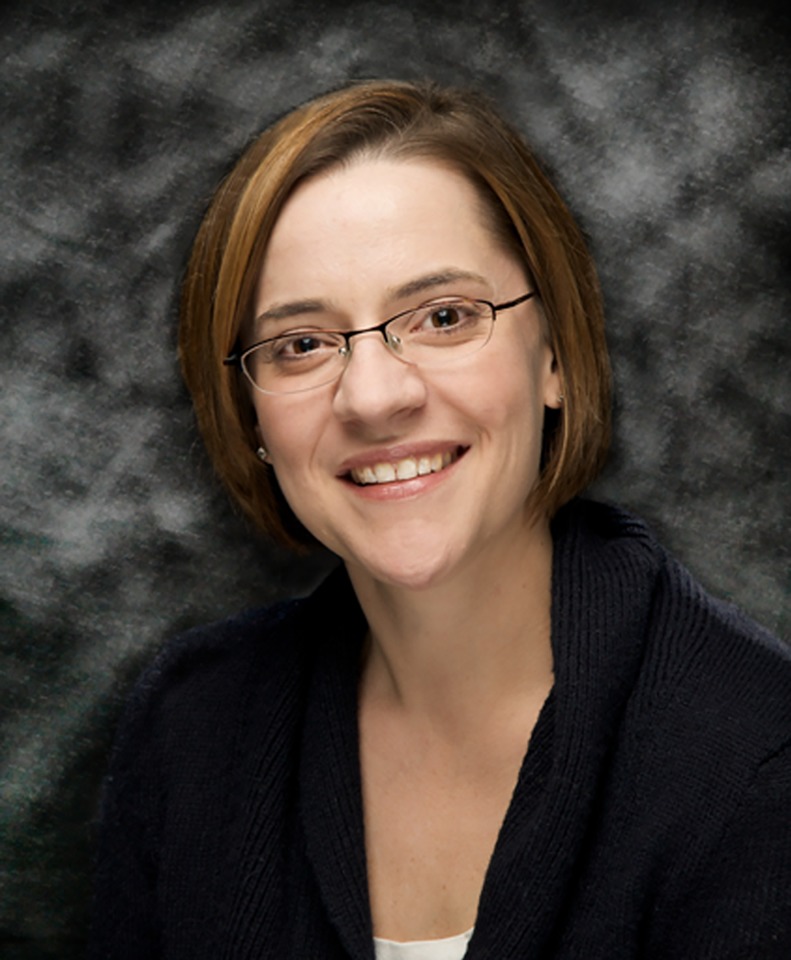
Carolyn B. Coyne.